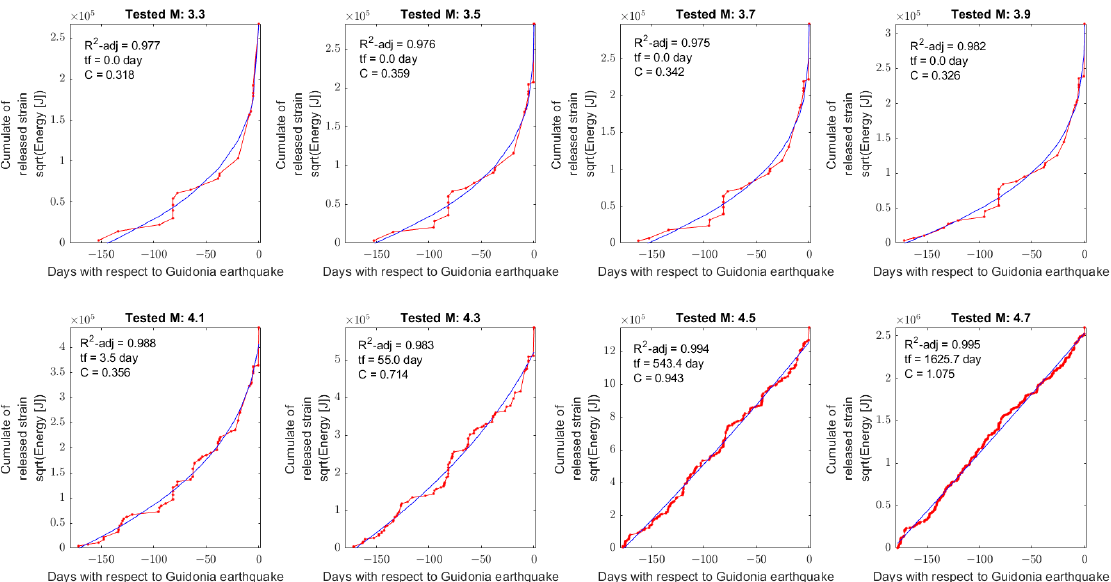
Figure 2. Benioff cumulative stress curves (in red) calculated within six months of the ML = 3.3 1 January 2023 Guidonia earthquake. Each graph is based on a circular area centred on the 1 January 2023 ML3.3 Guidonia earthquake with a Dobrovolsky’s radius of earthquakes with a magnitude from 3.3 to 4.7. For each plot, the blue curve represents the time-to-failure power law fit, whose adjusted coefficient of determination R 2 -adj and the time to failure (tf) are reported. The acceleration coefficient C is also reported.